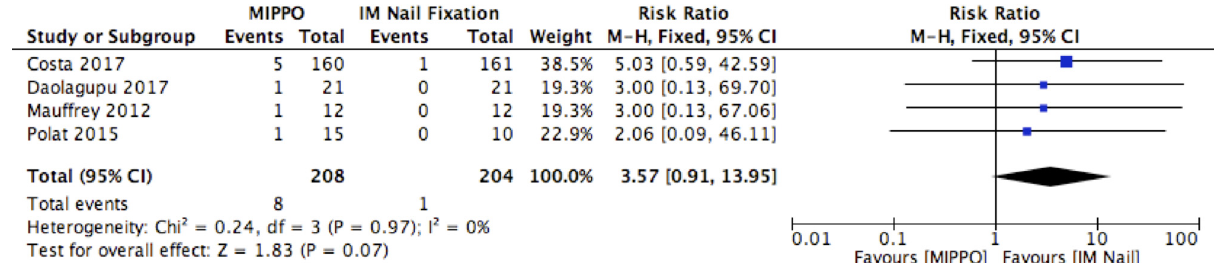
Fig. 7. Deep infections.